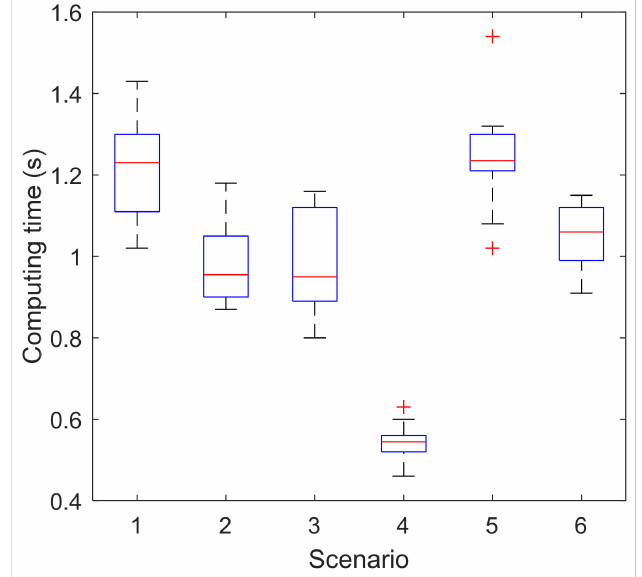
Figure 11. Boxplot of the computing time for six different